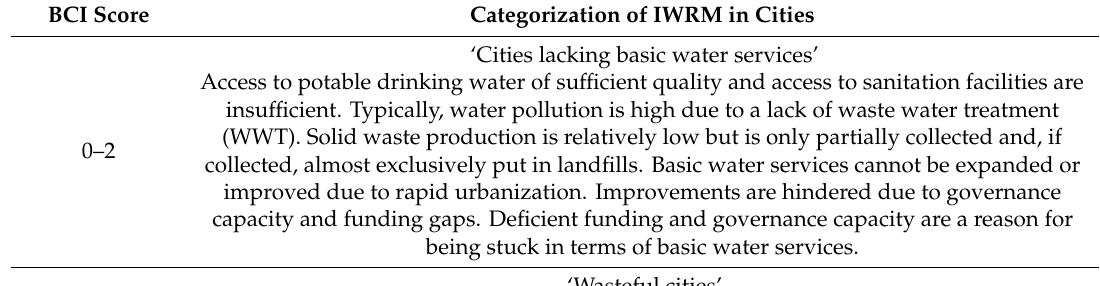
Table 3. Categorization of di ff erent levels of IWRM